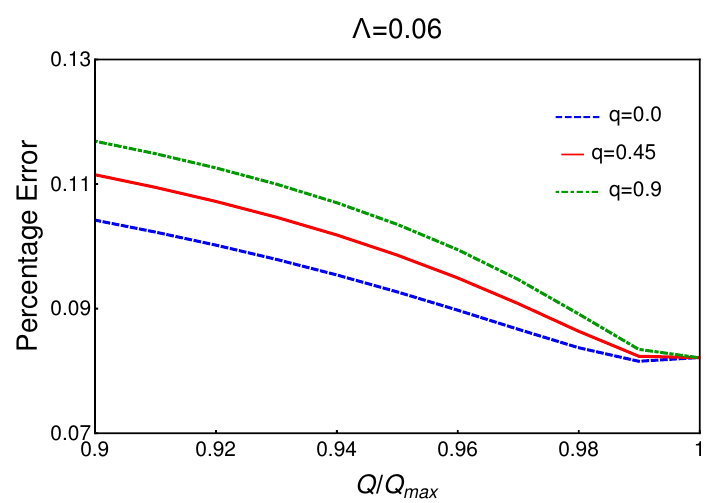
Figure 2 . Percentage error in the analytical expression of the parameter (cid:12) ph against the numerical estimates as a function of ( Q=Q max ) has been depicted for a (cid:12)xed value of the cosmological constant ((cid:3) = 0 : 06) for three di(cid:11)erent choices of the tidal charge q . As evident, the error decreases with increase of q and on the average the error stays at (cid:24) 0 : 1%. However with increase of ( Q=Q max ) the error decreases and reaches a value (cid:24) 0 : 08% in the extremal